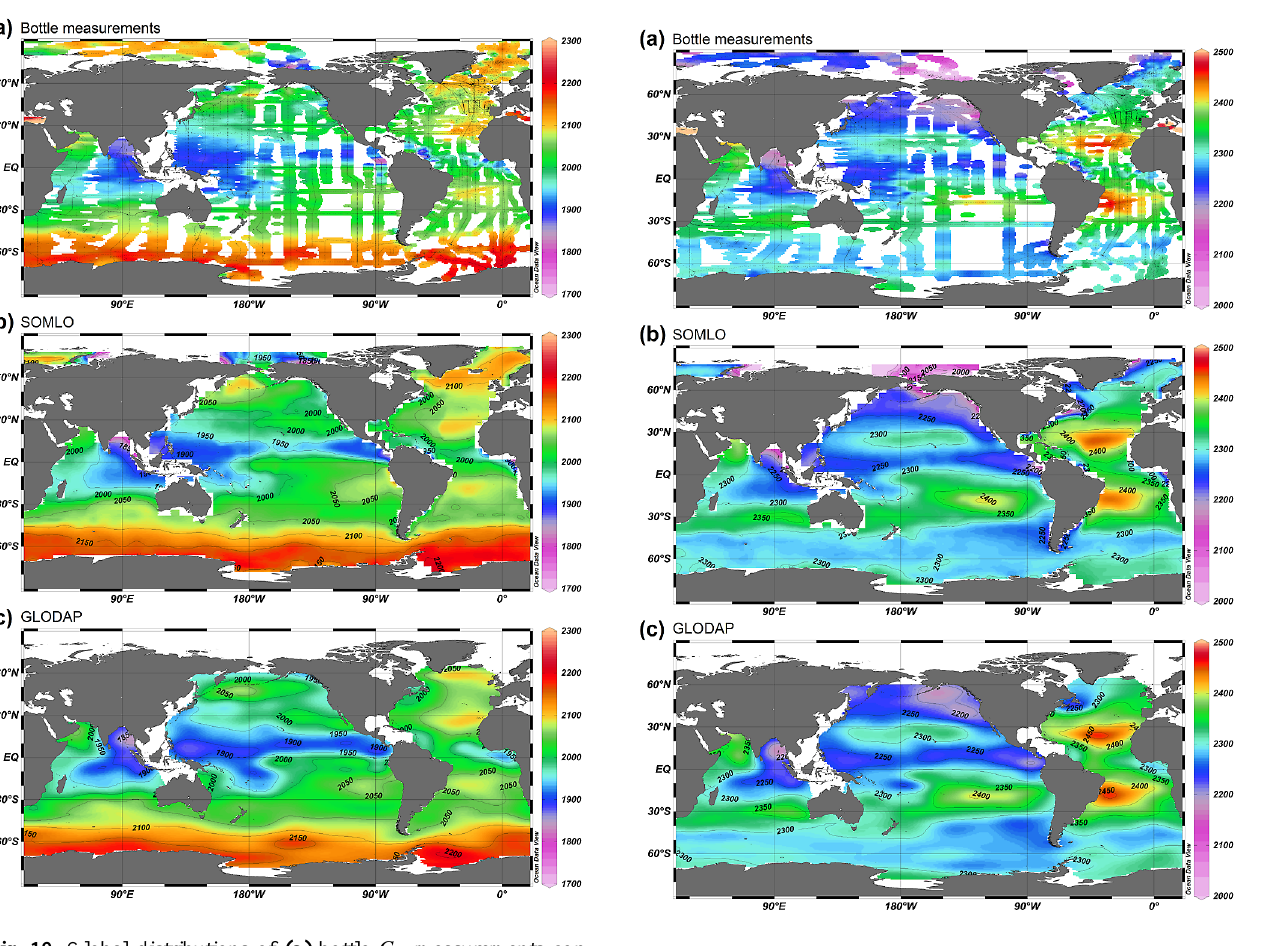
Fig. 20. Global distributions of (a) bottle A T measurements (b) annual-mean SOMLO A T predictions (c) GLODAP-v1.1 ocean sur- face A T distribution of Key et al.